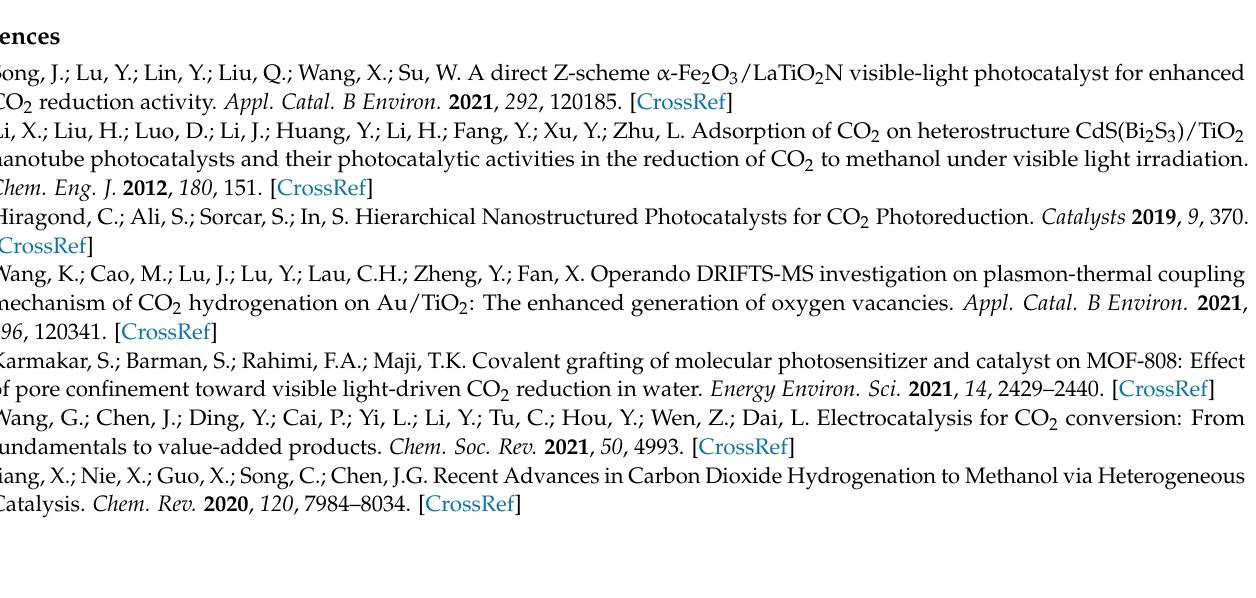
Figure S3: (a) UV-vis diffusion spectra and Tauc plot of PCN-222(2H), (b) Mott-Schottky plots of PCN-222(2H), (c) UV-vis diffusion spectra and Tauc plot of PCN-222(2H&Pt), (d) Mott-Schottky plots of PCN-222(2H&Pt), (e) UV-vis diffusion spectra and Tauc plot of PCN-222(2H&Fe), (f) Mott-Schottky plots of PCN-222(2H&Fe), (g) UV-vis diffusion spectra and Tauc plot of PCN-222(2H&Cu), (h) Mott- Schottky plots of PCN-222(2H&Cu), (i) UV-vis diffusion spectra and Tauc plot of PCN-222(2H&Mn), and (j) Mott-Schottky plots of PCN-222(2H&Mn); Figure S4: (a) The average CO yield, (b) EIS and (c) solid-state PL spectra excited at λ = 350 nm of PCN-222(2H), PCN-222(2H&Zn) and PCN-222(Zn); Table S1: Structural characteristics of PCN-222 materials; Table S2: Summary of photocatalytic CO 2 reduction performances of porphyrin-based MOFs materials in water or water vapor without the use of any organic solvent, photosensitizer, and sacrificial